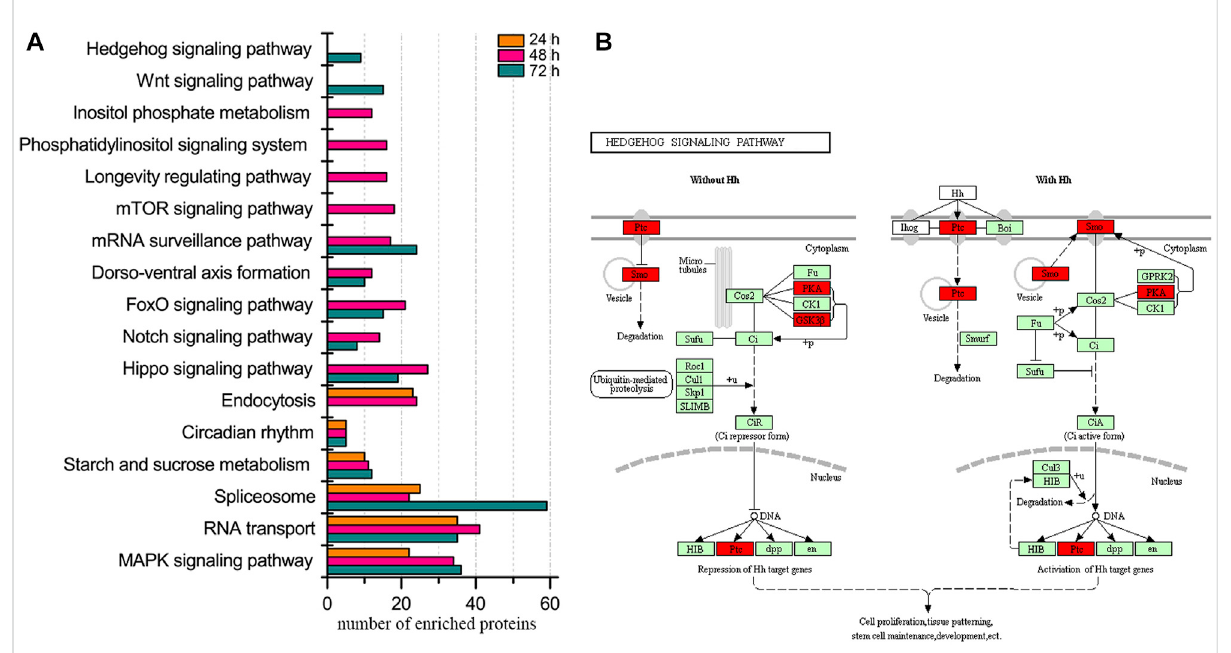
FIGURE 1 Biological pathway enrichment of identi fi ed proteins in the embryos of honey bee workers. (A) Comparison of enriched biological pathways of the identi fi ed proteins in the embryo of the honey bee workers aged 24, 48, and 72 h. Signi fi cantly enriched pathways are analyzed by KEGG Orthology-Based Annotation System (KOBAS, https://kobas.cbi.pku.edu.cn). A hypergeometric statistic test conducts the pathway enrichment. The Benjamini and Hochberg FDR correction is used to correct the probability values, and only the corrected p < 0.05 is considered statistically signi fi cantenrichedpathways. (B) RepresentativeenrichedpathwaymapfromKOBAS.Greenlabeledboxesaretheproteinreferencesofhoneybees annotated to the KEGG PATHWAY database. Highlighted red ones indicate the protein entries mapped to the signi fi cantly enriched